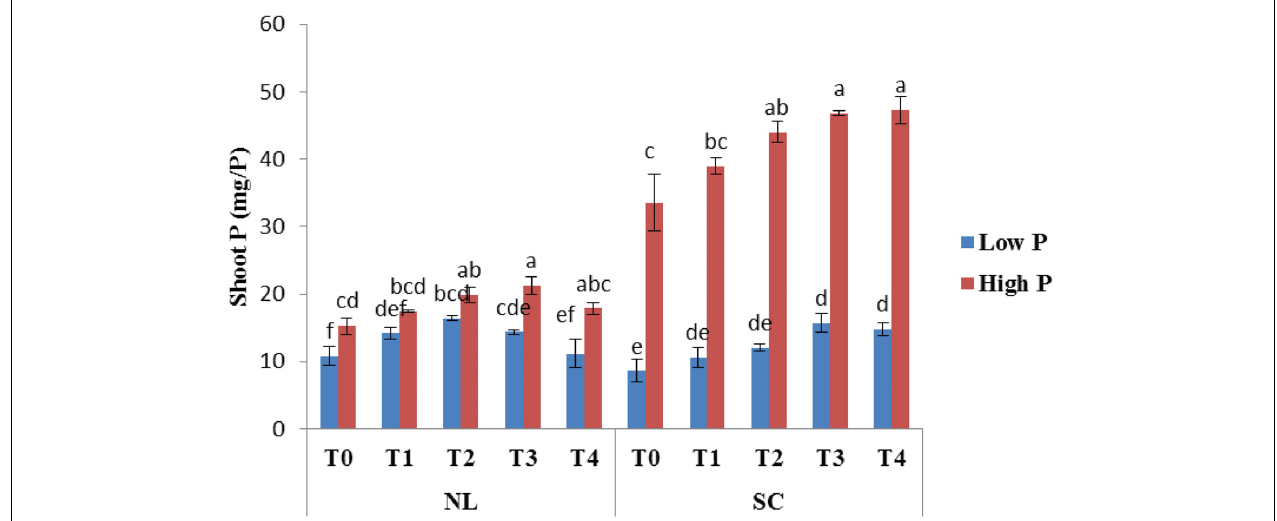
FIGURE 13 | Effect of Ti application on shoot P content of soybean under NL and SC combined with LP and HP conditions. The bar plots with different lettering show the significant difference among cultivars at probability < 0.05. The error bars are the ± SD values with n =